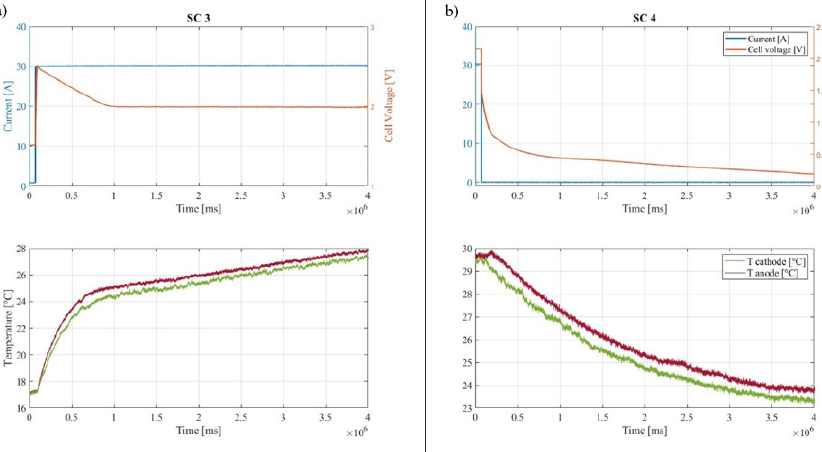
Figure 7. Obtained experimental results: ( a ) SC3 (0–30 A), and ( b ) SC4 (30–0 A).